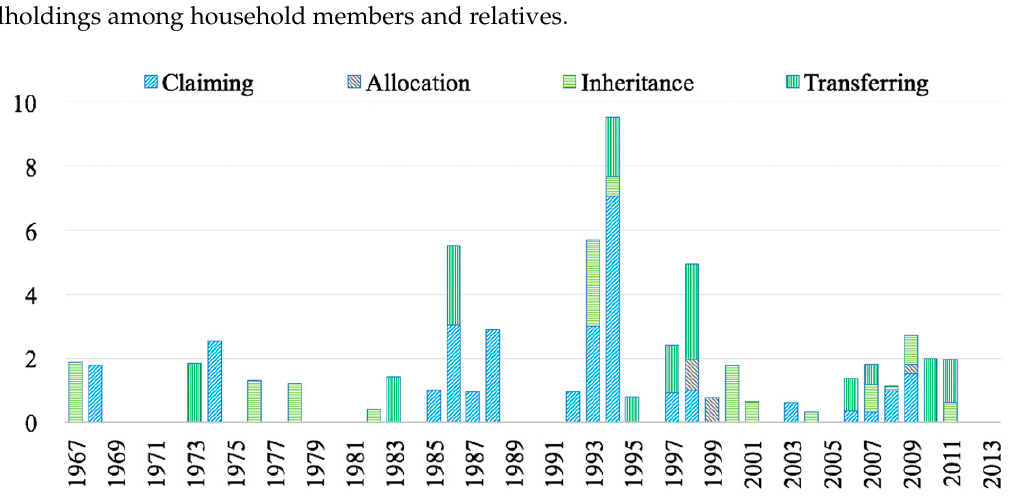
Figure 7. Sample households that obtained upland agricultural land. Source : Household survey. (2) Agricultural Area and Forestland within Groups of Households Figure 8 compares the average area of agricultural land obtained by the sample households between original and migrant households in three periods: before 1993, from 1993 to 2008, and from 2009 to 2013. The average of claimed agricultural area, both paddy and upland agricultural, obtained by the original households is larger than the area claimed by migrant households. Conversely, the average agricultural land area held by migrant households through a transfer process is larger than the area obtained by the original households. Meanwhile, there are differences in the ways original households and migrant households obtained their land. Original households had the opportunity